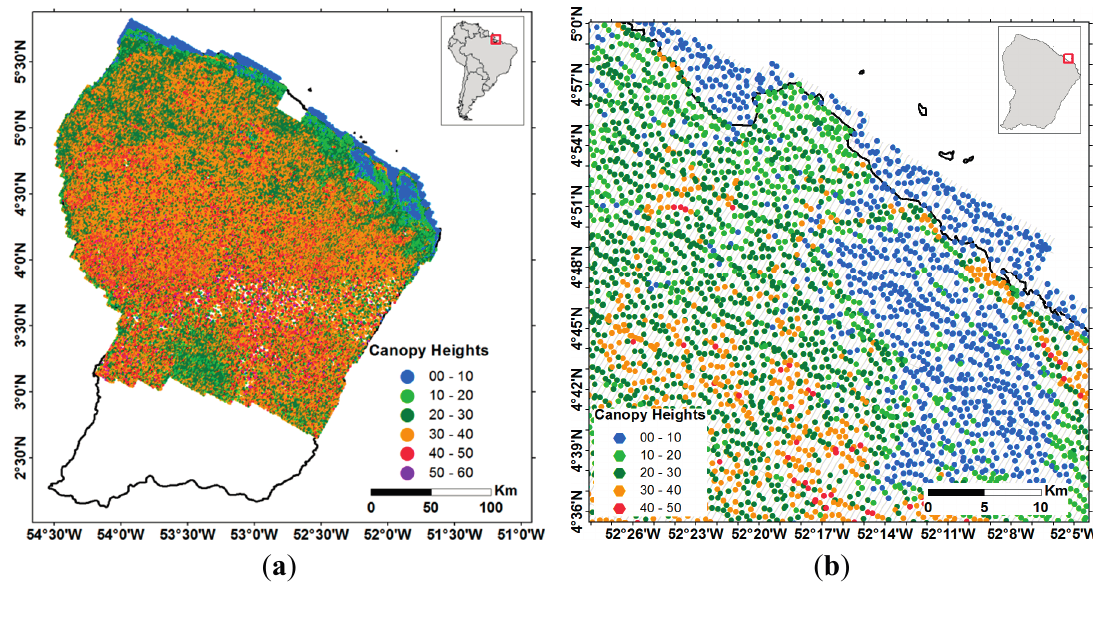
Figure 4. Map of canopy heights calculated from the airborne LiDAR dataset LD for ( a ) French Guiana and ( b ) a portion of the coastal marsh. Only 1% of canopy heights were higher than 50 m in all of French